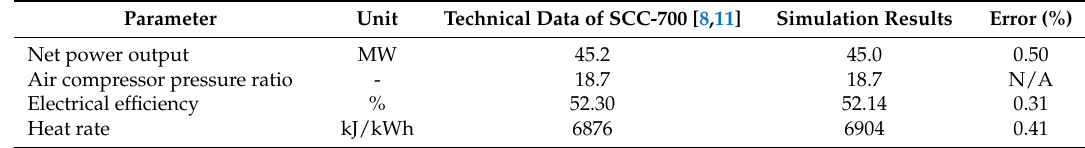
Table 7. Comparison of technical data and simulation results for gas turbine combined cycle. N/A—not